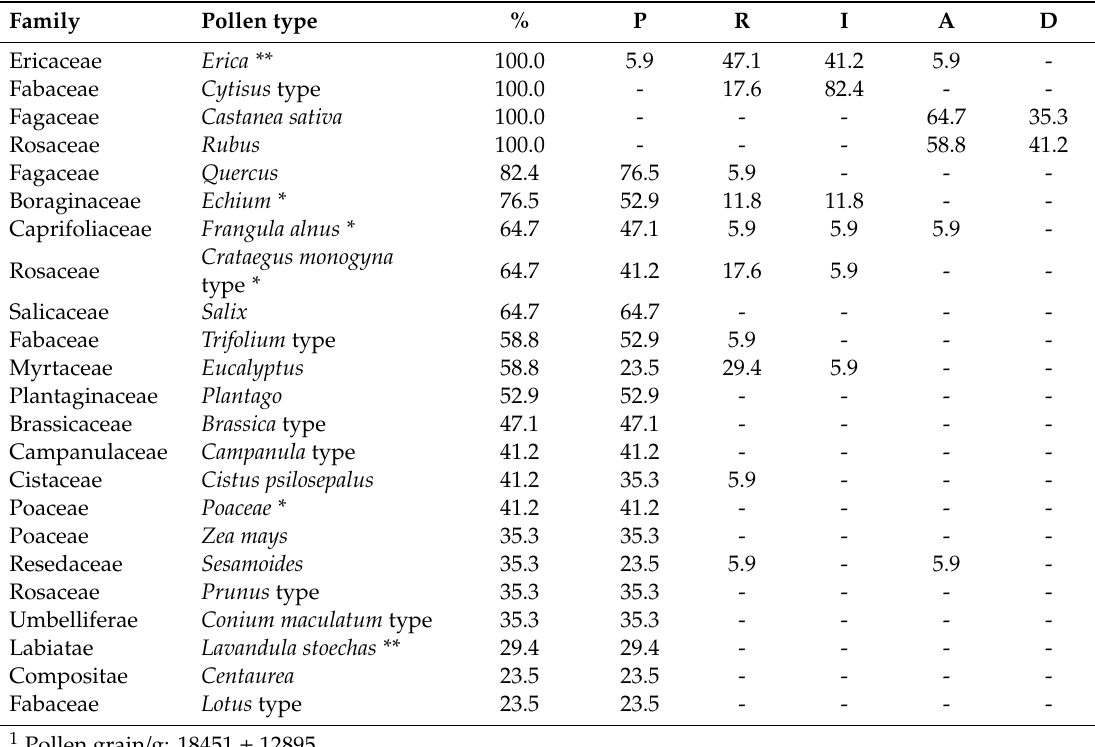
Table 1. Percentage of representation and frequency classes of the main pollen types in oak honeydew